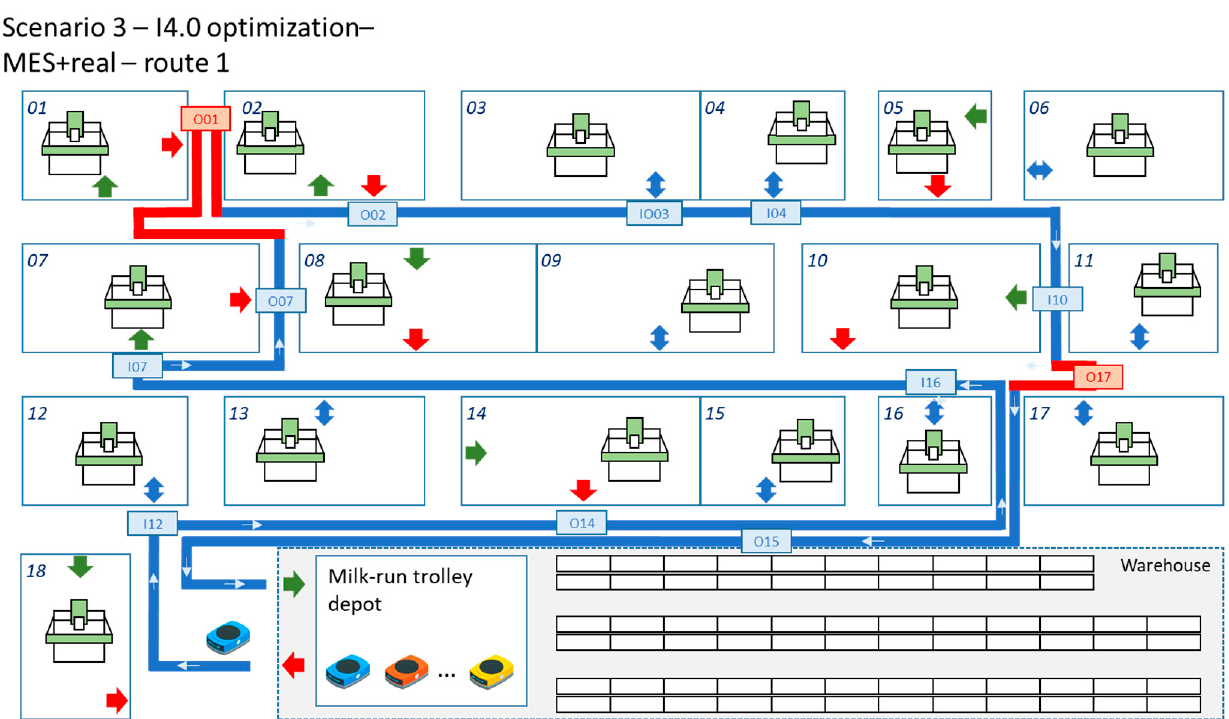
Figure 11. The modified first route of the I4.0 technologies supported real-time milk-run-based in-plant supply including MES data-based supply demands and digital-twin-generated real-time supply demands. Red lines of the route represent the real-time added route segments. Table 9. Numerical results of the scheduling of predefined and real-time-generated specific in-plant material supply operations performed by the milk-run trolley within route 1. The colored rows rep- resent the real-time added supply demands generated by the supervisory level using the results of the optimization based on the digital twin model.